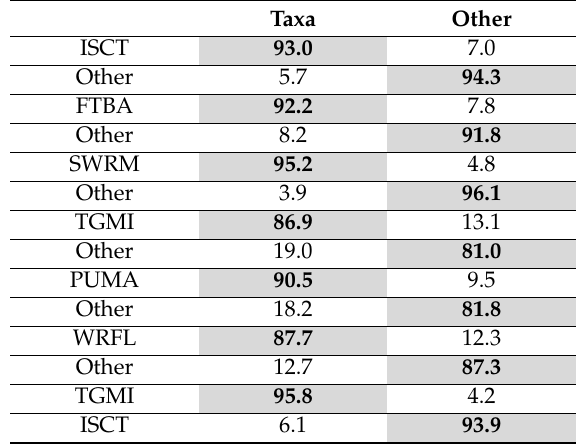
Table 4. Classification results of seven binary RF models, each focused on a specific scatterer type at the lowest level of aggregation. Values are percent of the total out-of-bag samples assigned to that class. “Taxa” refers to the corresponding focal class (e.g., ISCT, TGMI) in each confusion matrix. Percent true positive classifications are highlighted and bold. “Other” is a class of resolution cells equally represented by all non-focal